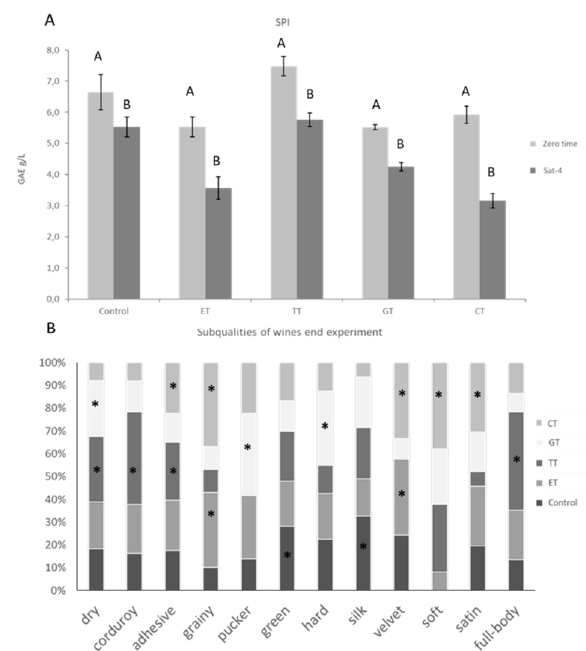
Figure 5. ( A ) Saliva Precipitation Index (SPI, g / L of gallic acid equivalent, GAE), ( B ) subqualities of Figure 5. A) Saliva Precipitation Index (SPI, g/L of gallic acid equivalent, GAE), B) Subqualities of 411 wines at the end of the experiment. Di ff erent letters indicate a statistically significant di ff erence in SPI wines at the end experiment. Different letters indicate a statistically significant differences in SPI 412 before and after the oxidation oxygen treatment (A, B), while for a di ff erent stage of oxygen saturations before and after the oxidation oxygen treatment (A, B), differences among subqualities of wines at the 413 (a, b, c) di ff erences among subqualities of wines at the end experiment are denoted with an asterisk end experiment are denoted with an asterisk (p<0.05). 414 ( p <